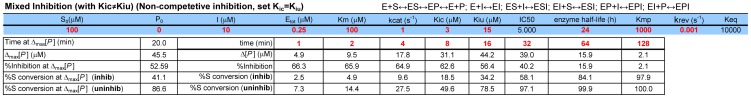
Screen dump of a subsection of the simulation tool.The tool contains three blocks (one for competitive, one for uncompetitive, and one for mixed inhibition; non-competitive inhibition is achieved by setting the two K
i values for mixed inhibition to equal values) in which the reaction parameters and variables can be set. The block for mixed inhibition is shown. Adjustable values are shown in red and are found in the second row of each block. The identities of the adjustable values are shown in the top row. The resulting IC50 value and overall equilibrium constant of the reversible reaction are also shown in the top row. A table presents the time point of Δmax[P] and the associated key data that result from adjustment of reaction conditions. To deduce the corresponding data at other time points, the desired values can be entered into cells of the top row of the table. In the simulation tool, changes of reaction conditions are also visualized in various graphs.